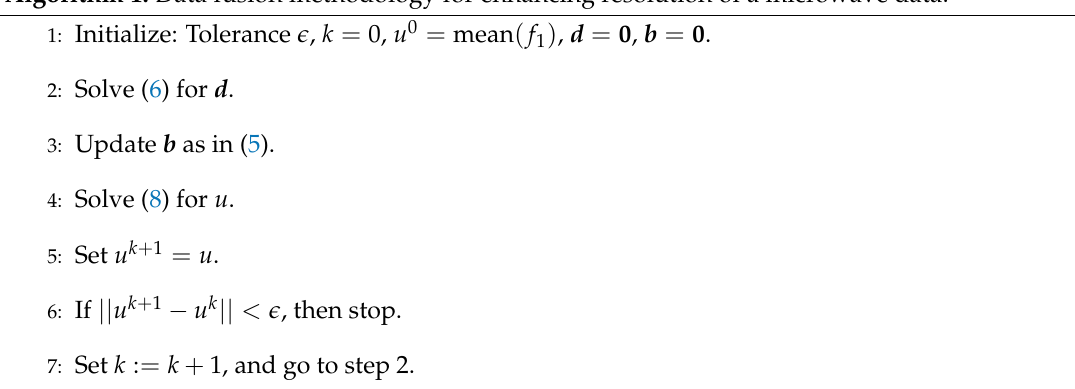
Algorithm 1 below is a description of the developed data fusion method. Algorithm 1: Data fusion methodology for enhancing resolution of a microwave